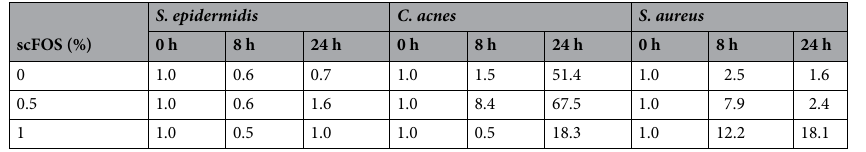
Table 3. Bacterial strains growth on reconstructed human epithelium (RHE). Spread plate colony count of S. epidermidis , C. acnes and S. aureus following RHE colonization and exposure to different concentrations of scFOS for 0, 8 and 24 h, expressed as fold-change compared to the initial bacterial load.